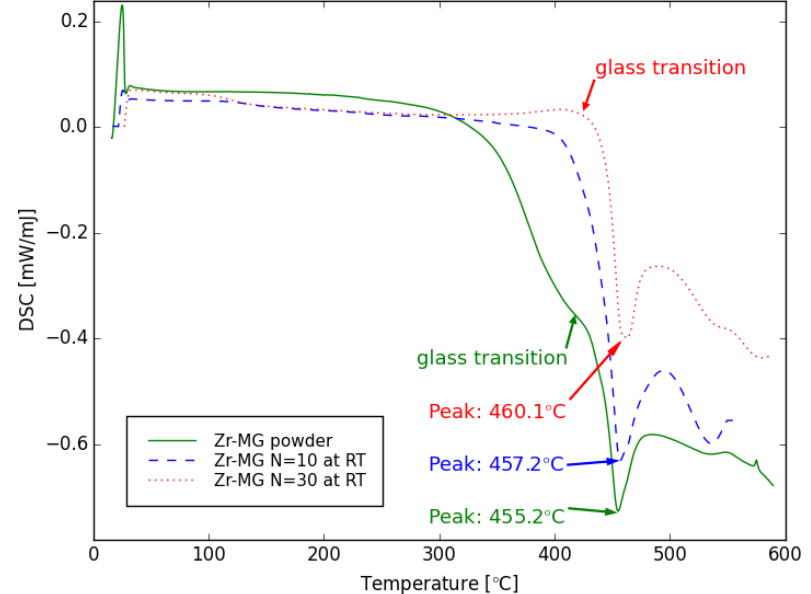
Figure 6. Differential scanning calorimetry (DSC) measurements exclude a crystallization during HPT deformation. The powder as well as the HPT disks show a distinctive crystallization peak at 457 ◦ C, 455 ◦ C and 460 ◦ C, respectively. The peak breadth and position are nearly the same, which indicates an amorphous structure for all. The difference in the onset of crystallization and in the transition temperature is caused by structural relaxation due to the HPT